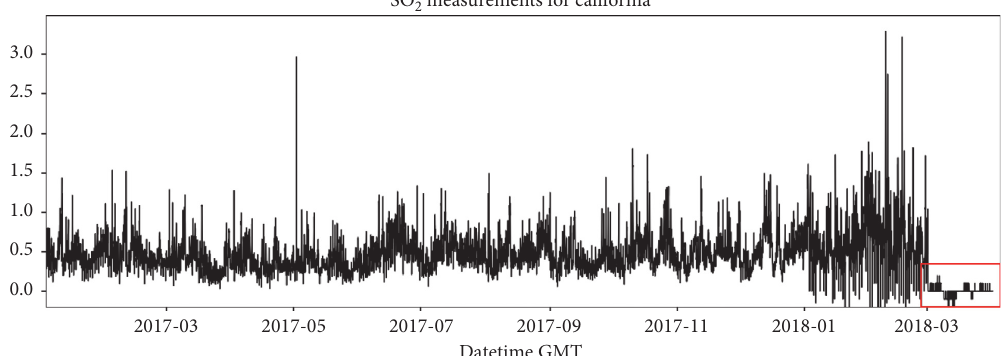
Figure 4: Abnormal behavior detected for SO